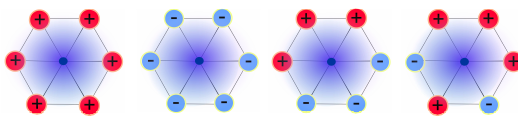
Figure 3. The types of vertices on a triangulated mesh. From left to right: minimum, maximum, regular vertex, and